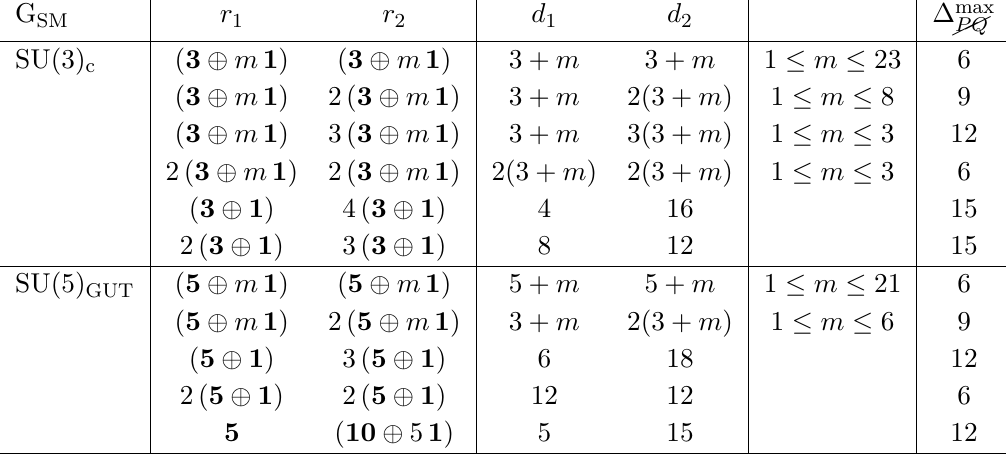
Table 3 . Choices of representations for models with n f = 2 . The full list of possibilities contains also theories that are obtained by replacing any of the irreducible representations in this table with its conjugate. In the case of the SU(3) theories listed in the upper panel, electroweak quantum c numbers are not specified but can be assigned freely as long as the conditions from cancellation of gauge anomalies and perturbativity of gauge couplings are